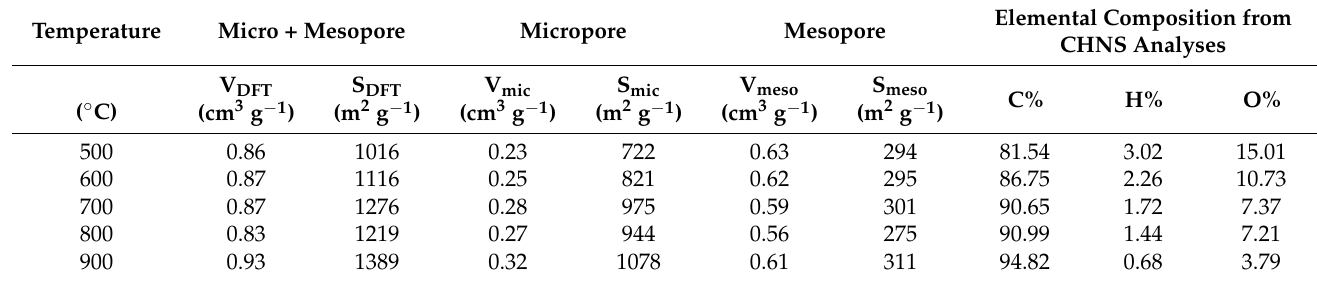
Table 1. Effect of carbonisation temperature on porous texture and elemental compositions of CXs.